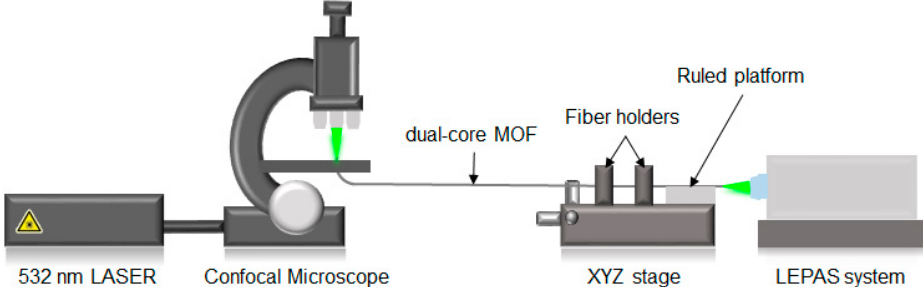
Figure 3. Schematic diagram of the experimental set-up used to measure the coupling length using the cut-back technique.